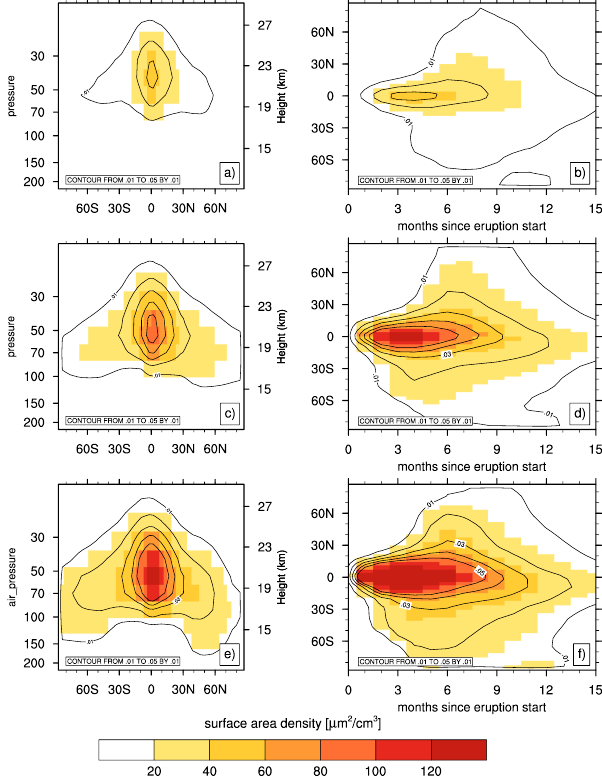
Figure 1. Aerosol data sets used in the simulations for the 15Tg (a, b) , 30Tg (c, d) , and 60Tg (e, f) SO 2 aerosol forcing. Surface area densities (SADs) are displayed by colours; contours denote extinction rates in the visible (440–690nm) with contours from 0 to 0.05 by an interval of 0.01km − 1 . The column on the left displays averages for the first post-eruption winter season (DJF) as a function of pressure and latitude, while the right column shows Hovmöller diagrams of the monthly mean SAD forcing at